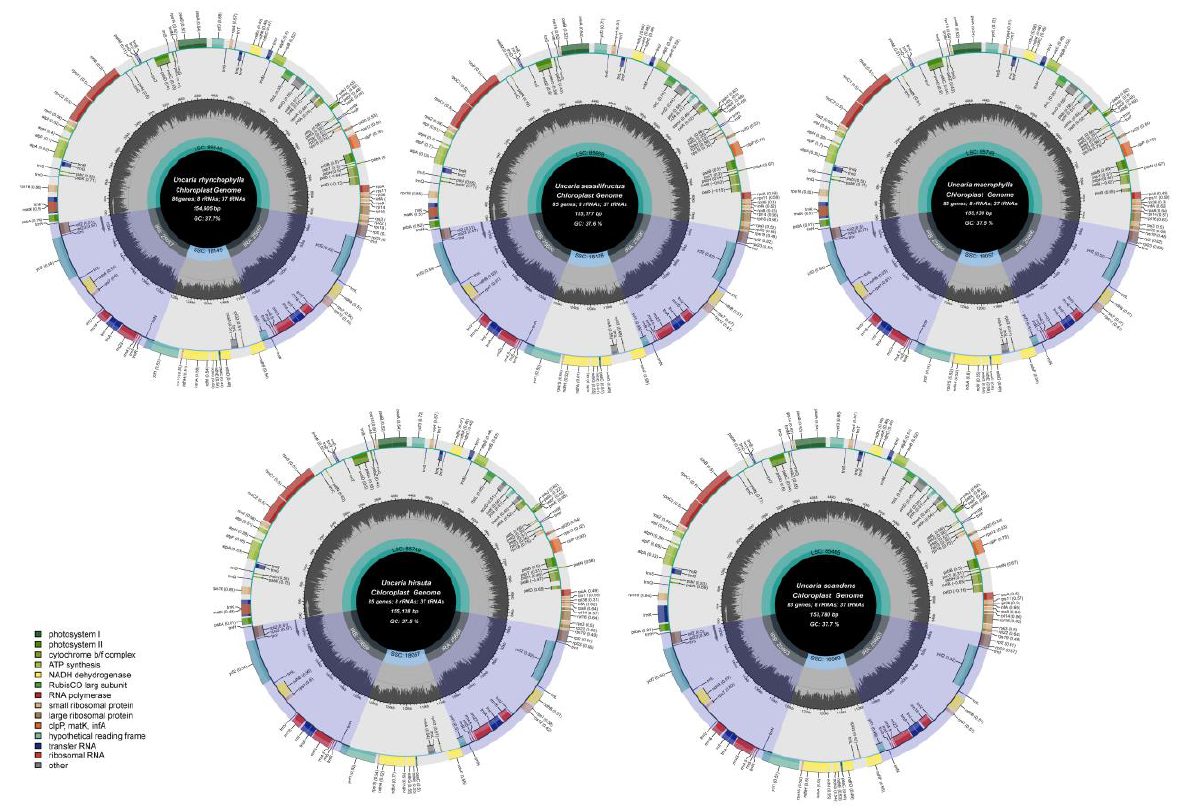
Figure 2. The complete chloroplast maps of five species in Uncaria . The gene in the circle is transcribed clockwise while the gene outside is transcribed counterclockwise. Genes are color-coded according to their roles. The AT content is shown in the lighter grey, while the GC content is shown in the deeper grey in the center circle.